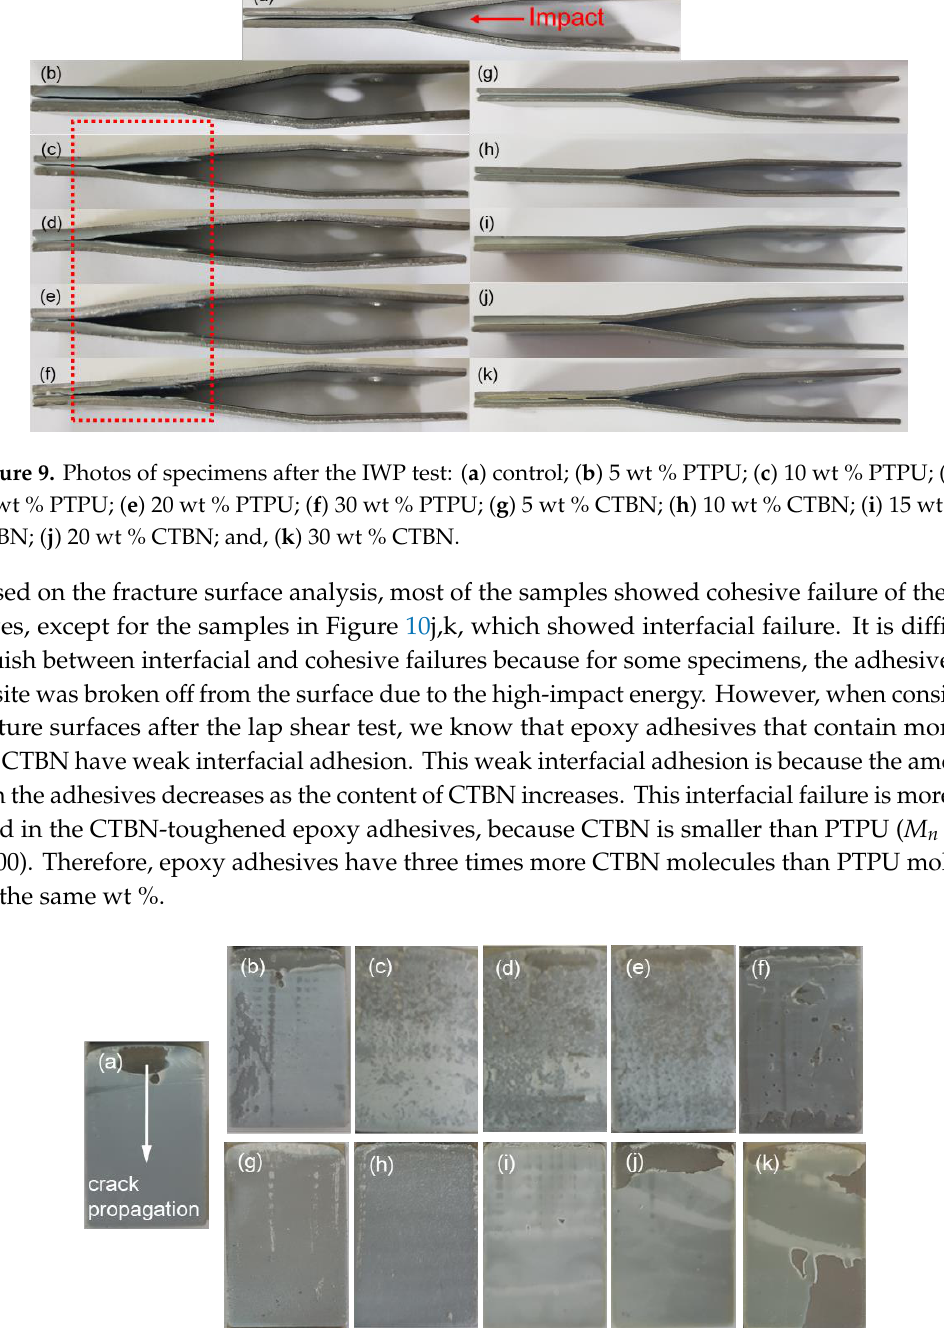
Figure 10. Fracture surfaces of IWP specimens: ( a ) control; ( b ) 5 wt % PTPU; ( c ) 10 wt % PTPU; ( d ) 15 wt % PTPU; ( e ) 20 wt % PTPU; ( f ) 30 wt % PTPU; ( g ) 5 wt % CTBN; ( h ) 10 wt % CTBN; ( i ) 15 wt